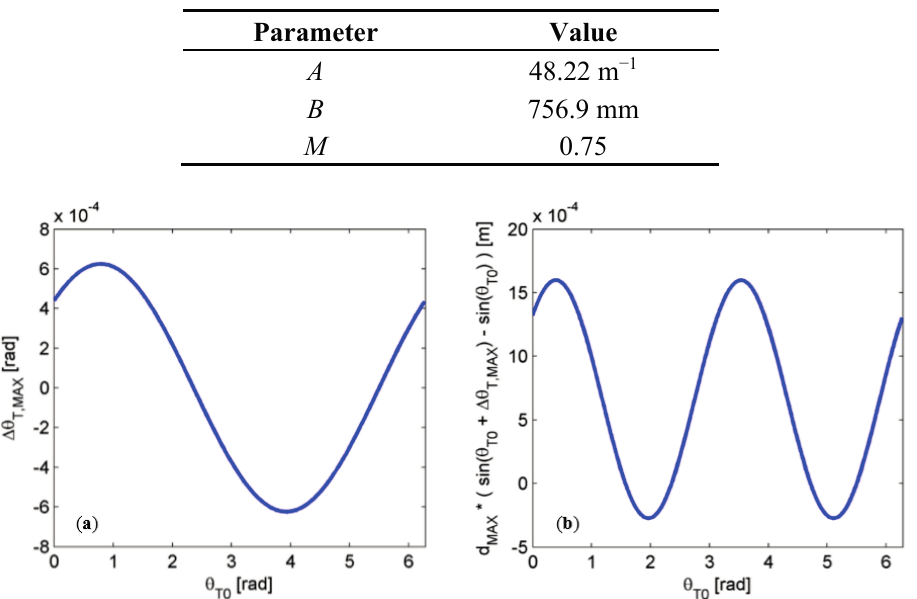
Figure 5. Maximum errors Δρ T,MAX at d MAX = 3 m as a function of the mirror curvature and the baseline, computed for magnification equal to: ( a ) 0.75; ( b ) 1. Regions where the laser incidence is out of the camera FoV are displayed in white. Table 4. List of design parameters that allow maximum error of 10 mm at a distance of 3 m.